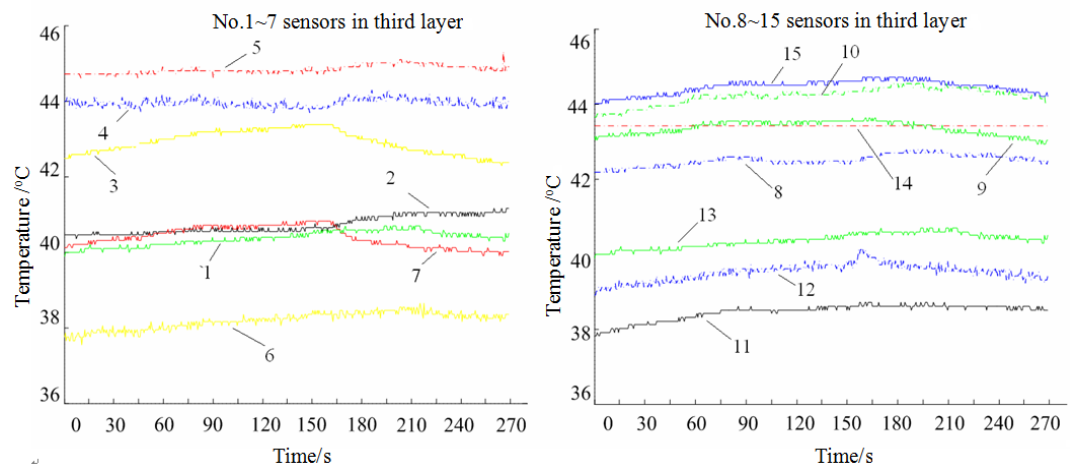
Figure 8. Temperature measurement in the third